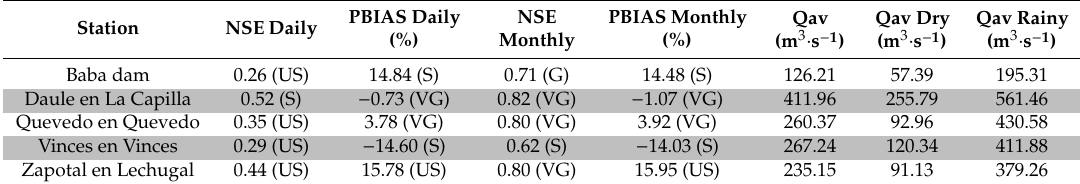
Table 2. Evaluation statistics with model performance assessment according to Moriasi et al. [82] and average registered streamflows (Qav, whole period; dry, dry season; rainy, rainy season) for the calibration period (1993–2000). The stations for which manual calibration was done are indicated in